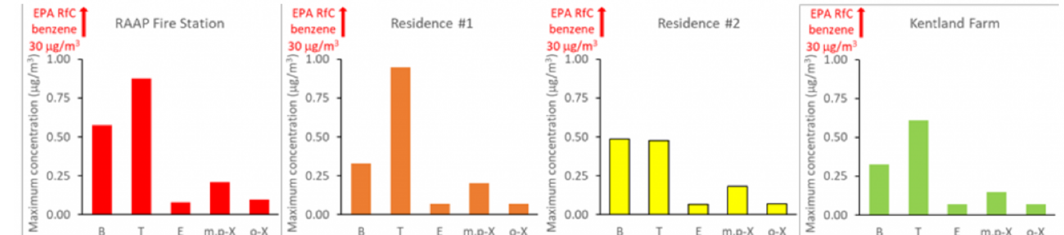
Figure 4. Maximum observed airborne concentrations of arsenic (As), cadmium (Cd), cobalt (Co), copper (Cu), nickel (Ni), and lead (Pb). Observed levels of all five elements were well below 0.15 μg/m 3 (indicated by a red line), which is the standard for lead, which has the most stringent air quality or workplace standard of the five elements.